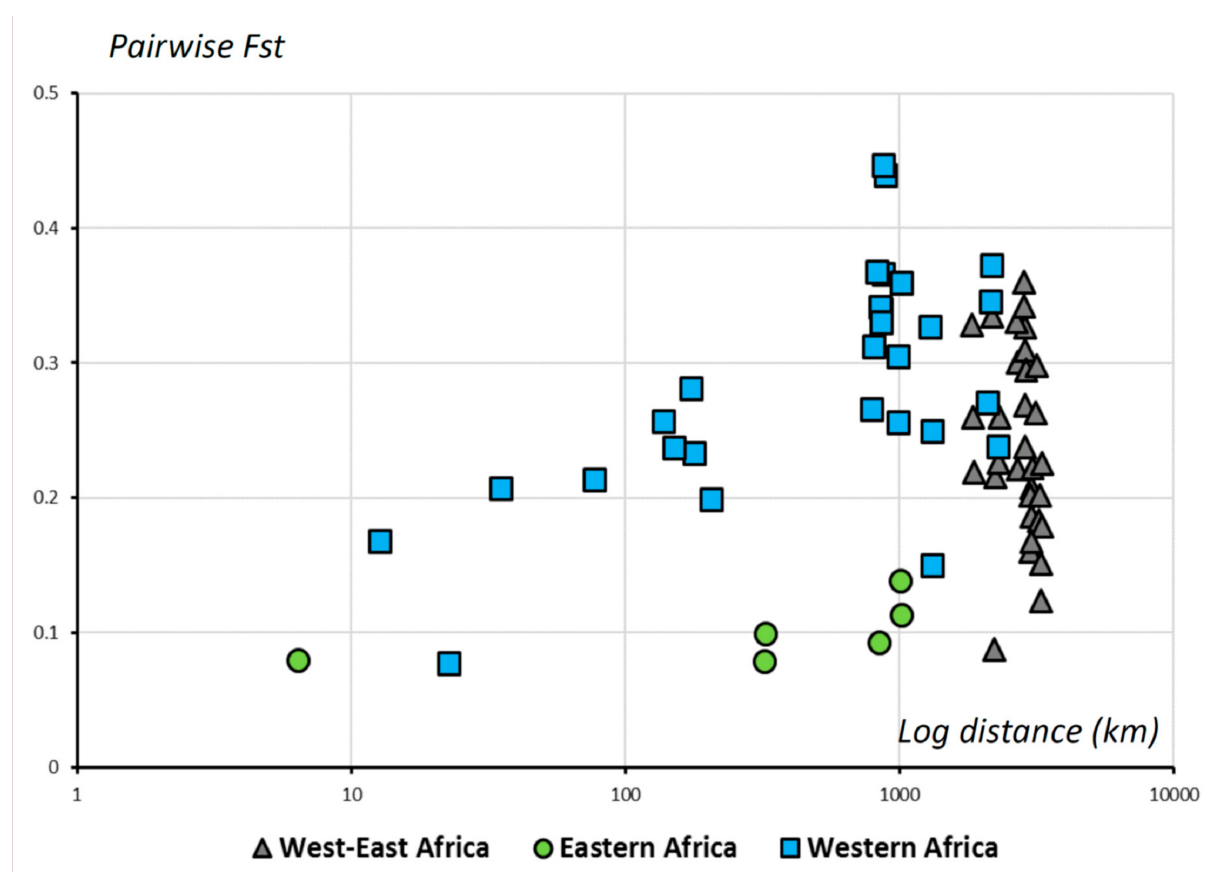
Figure 3. Pairwise genetic differentiation ( F ST ) in relation to spatial distances. We distinguish population pairs of P. latifolius sampled between western Central Africa and East Africa, within East Africa, and within western Central